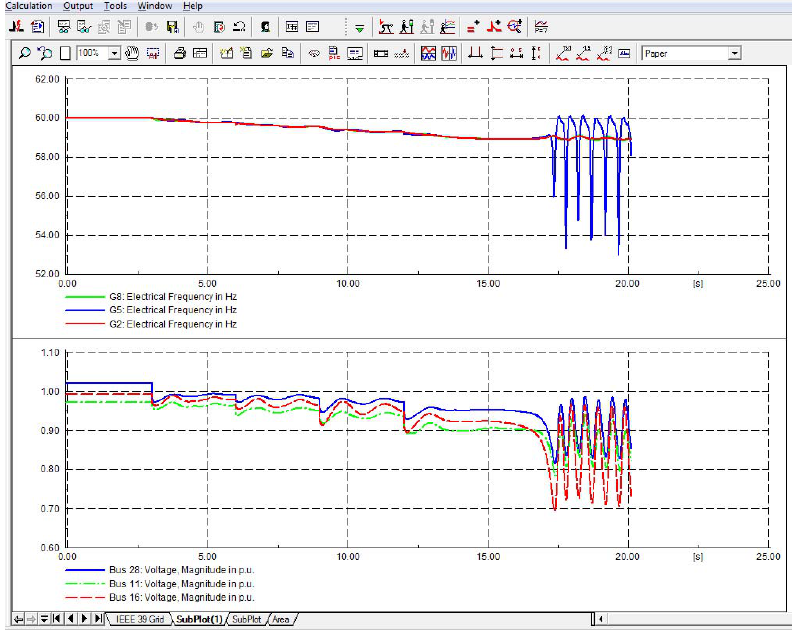
Figure 7. Dynamic simulation results.